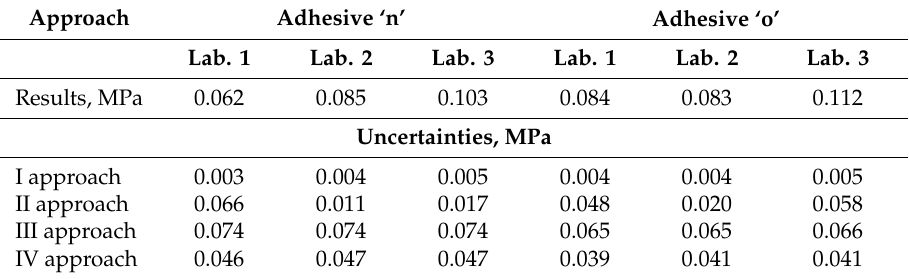
laboratories (1–3) and two materials: adhesive ‘n’ and adhesive